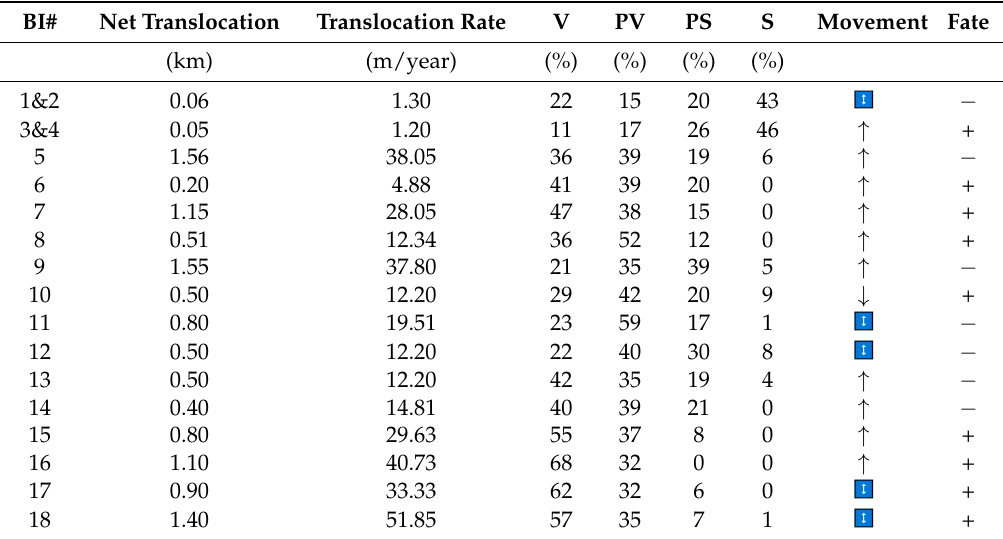
Table 2. Net translocation, translocation rate, vulnerability/sustainability status, movement and the fate of barrier